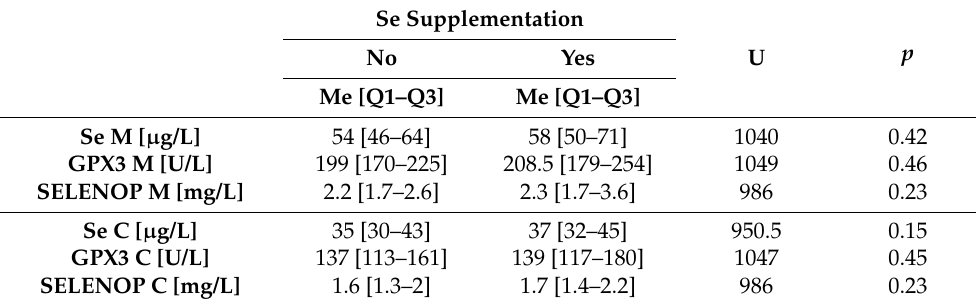
Table 4. Impact of supplementation on Se status in the mothers and the